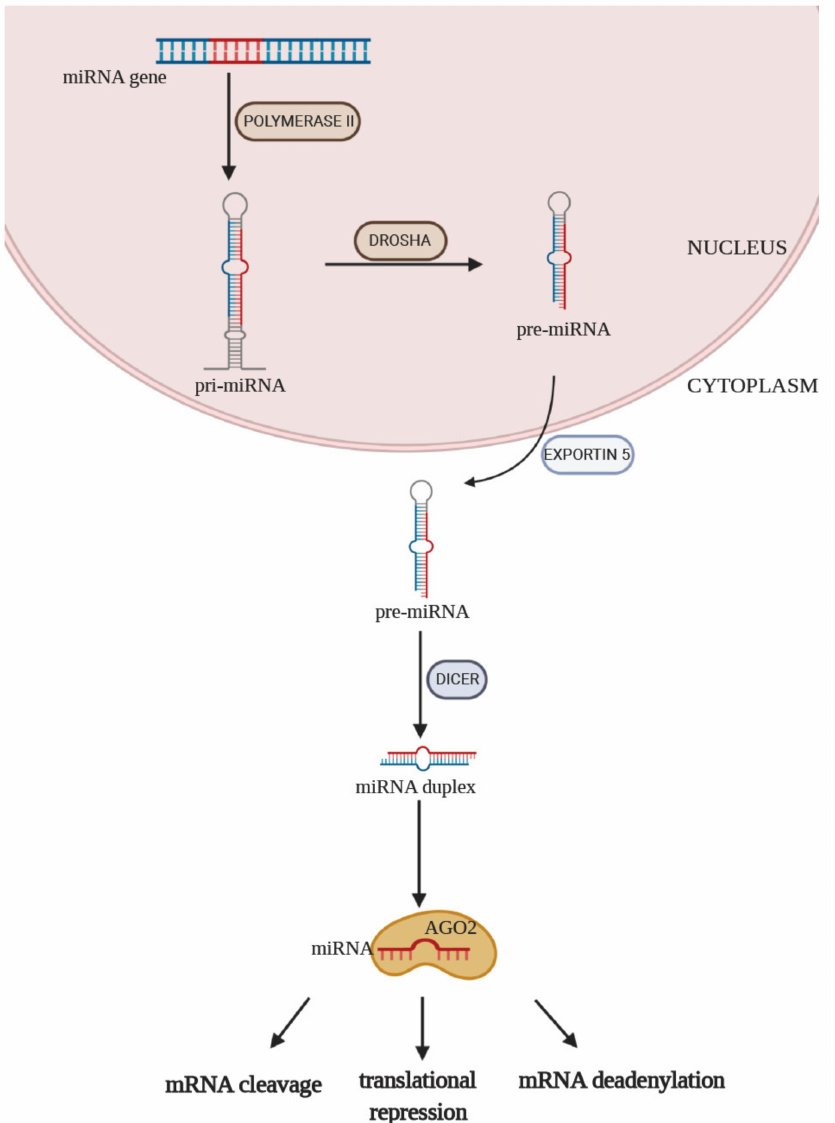
Figure 1. MiRNA biosynthesis and functions. Process of the biosynthesis of miRNA begins in the nucleus. MiRNA genes are transcribed by polymerase II to primary RNA (pri-miRNA). Pri-miRNA is processed to pre-miRNA with the participation of the ribonuclease Drosha. Subsequently, pre-miRNA is transported via Exportin 5 from the nucleus to the cytoplasm of the cell. Dicer is an endonuclease that cleaves pre-miRNAs into short miRNA duplexes, which are later unwound by an unknown helicase. The mature miRNA strand binds to an Argonaute (Ago) protein, forming a complex. Altered expression of miRNAs can be used as a disease biomarker as well as